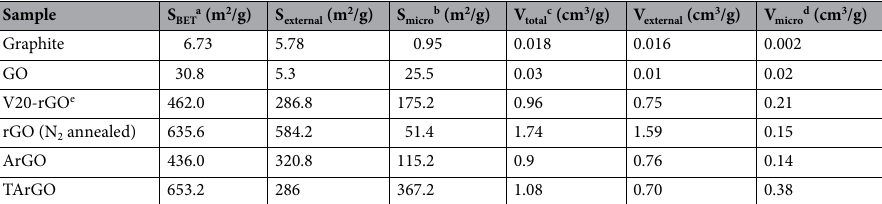
Table 1. Textural properties of prepared materials, including surface areas and pore volumes. a Brunauer– Emmett–Teller surface area calculated in the pressure range (P/P 0 ) of 0.01–0.12. b Micropore surface areas calculated from the N 2 adsorption isotherms using the t-plot method. c Total pore volume obtained at 0.99 of P/P 0 . d Micropore volume calculated using the t-plot method. e Commercial reduced graphene oxide (rGO) powder purchased from Standard